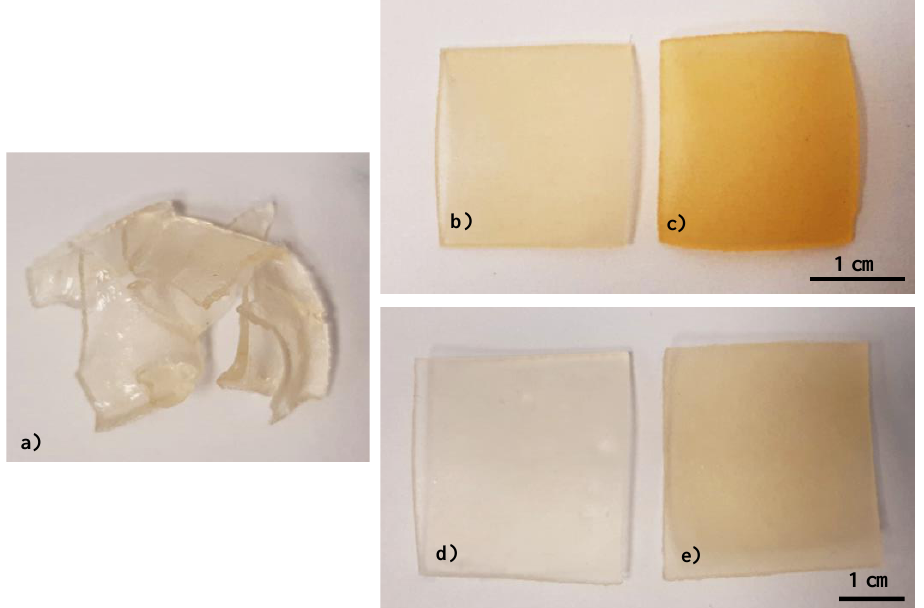
Figure 3. Images of obtained samples: non-crosslinked hydrogel—sample 33/3.2 ( a ); properly crosslinked unmodified sample 0/1.6 in a dry state ( b ) and in a swollen state ( d ); properly crosslinked modified sample 9/1.6 in a dry state ( c ) and after swelling ( e ).